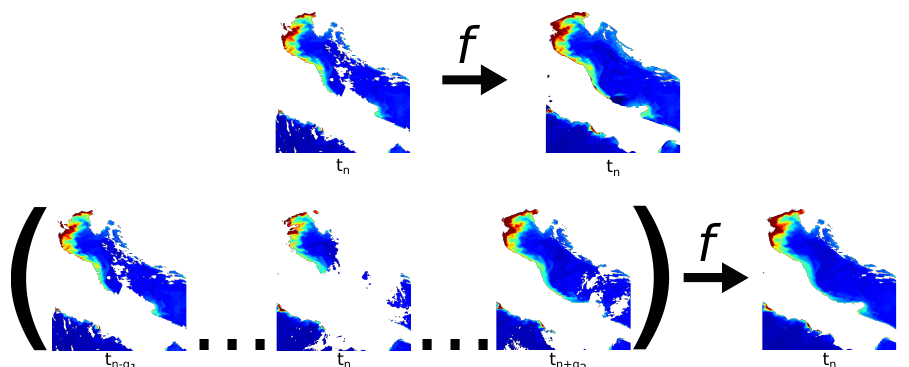
Figure 3. Examples of unitemporal (top row) and multitemporal (bottom row) approaches being used for chl a reconstruction. The targeted time-instance is t n . Both examples imply available data have been composited with reconstructed missing data to obtain complete data, x ( r , t n ) = x ( r a , t n ) ⊕ x ( r m , t n ) .